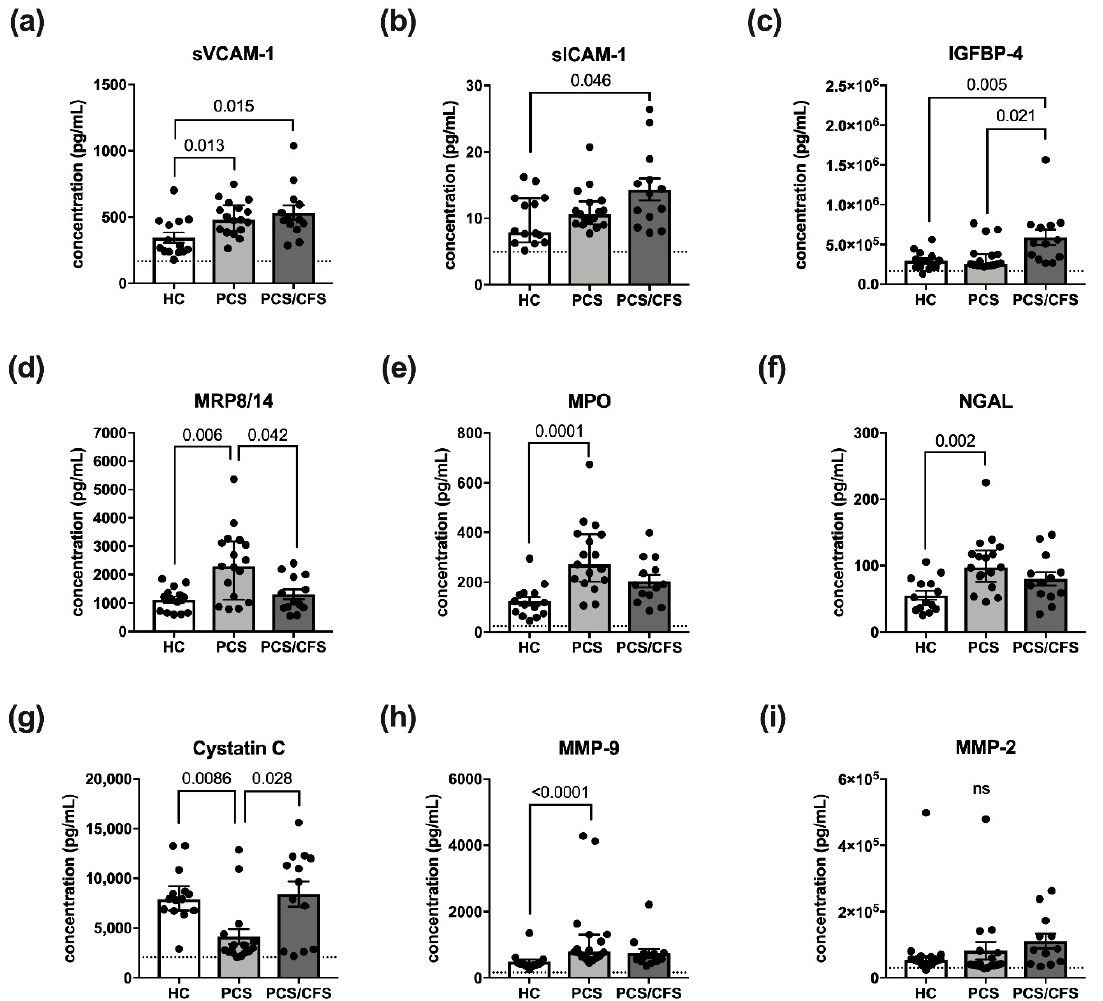
Figure 3. Vascular inflammation associated small molecules and their release by serum-treated cultured human endothelial cells. Briefly, cultured HUVECs were treated with 2% ( v / v ) patient (PCS, PCS/CFS) or control (HC) serum for 6 h. After a medium exchange, secretion was allowed to occur for 36 h. Shown are the results of a multiplex analysis using LEGENDPlex TM (BioLegend) vascular inflammation panel 1 to determine the concentrations (pg/mL) of ( a ) sVCAM-1, ( b ) sICAM-1, ( c ) IGFBP-4, ( d ) MRP8/14, ( e ) MPO, ( f ) NGAL, ( g ) Cystatin C, ( h ) MMP-9 and ( i ) MMP-2. Dotted lines denote baseline level of untreated HUVEC, absence of the line indicates levels below the lower detection limits. Shown are median, interquartile range and individual values of corresponding analyte concentrations. Statistical significance was determined using a Kruska-Wallis test. A p value ≤ 0.05 was considered significant. HC, healthy controls (n = 14). PCS, post-COVID-19 syndrome (n = 17). PCS/CFS, post-COVID-19 syndrome with ME/CFS (n = 13). ns, not significant ( p value >